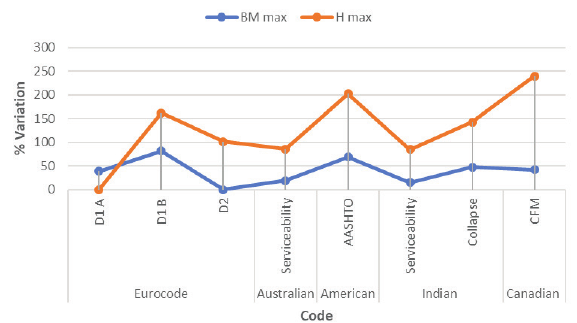
Figure 7: Comparison of percentage variation in B.M